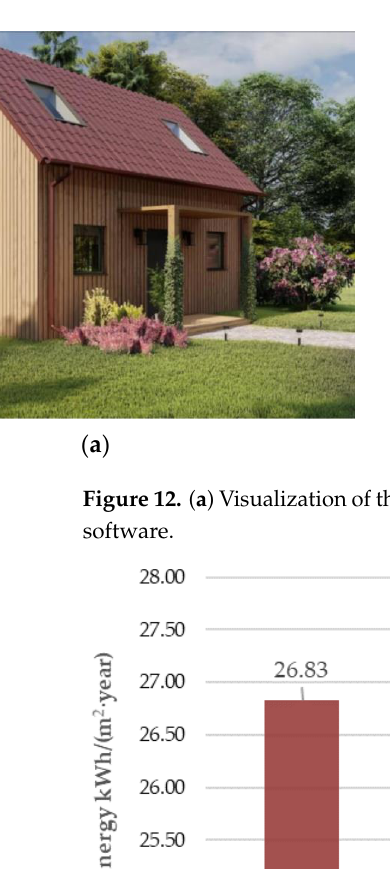
14 of 18 Figure 12. ( a ) Visualization of the selected building design; ( b ) Model made in ArCA- Dia-Architektura software. By changing the structure of the external walls, four variants with natural materials were created. The remaining models were exported to another Intersoft software, i.e., ArCADia TERMOCAD (Manufacturer name: INTERsoft sp z o.o. , Łódź, Poland) , which